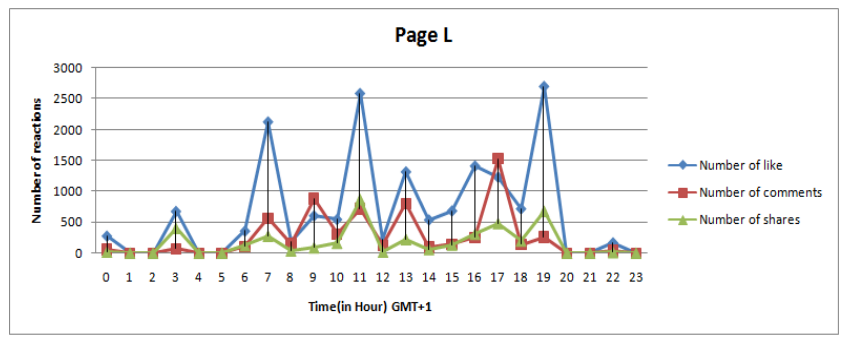
Fig. 8. Number of interactions per publishing hour for page L with 46